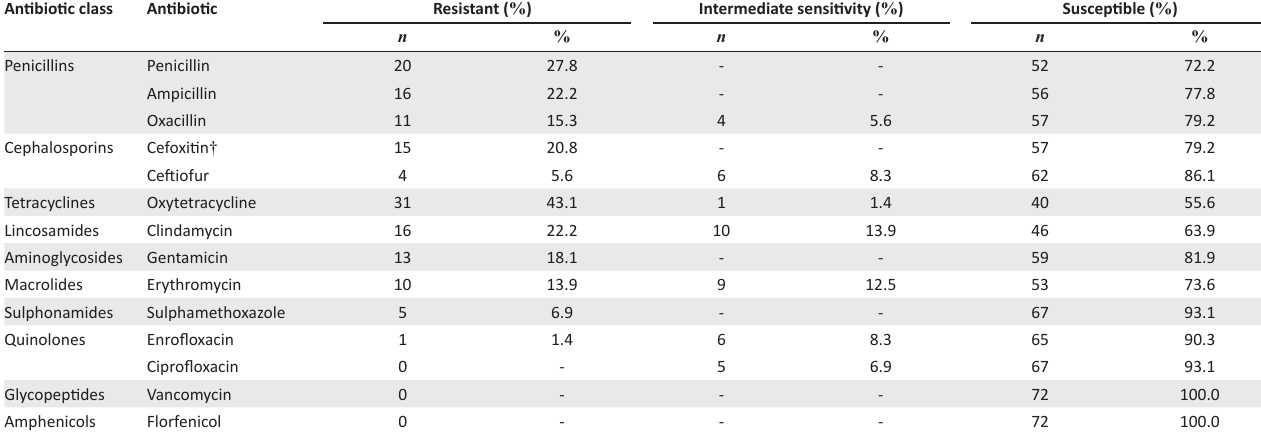
TABLE 4: Distribution of antibiotic-resisant Staphylococcus aureus isolates ( n = 72) from poultry meat products in South Africa,